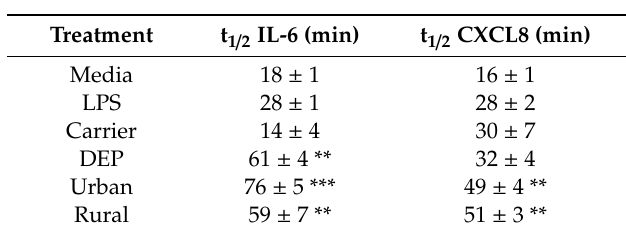
Figure 6. Post-transcriptional control and nuclear expression of CXCL8 in cells exposed to organic extracts from rural PM2.5, urban PM2.5 and DEP. ( A ) Time course of cells exposed to 25 µ g / mL of urban extract. ( B ) Time-course of cells exposed to 25 µ g / mL of rural extract. ( C ) Time course of cells exposed to 10 µ g / mL of DEP extract. ( D ) Induction of the transcription rate of CXCL8 transcript after 15 min of exposure to rural, urban, and DEP organic extracts. Values are expressed as the mean ± SEM ( n = 3). * p ≤ 0.05, *** p ≤ 0.001 compared to carrier. Table 1. Changes in mRNA Half-lives.